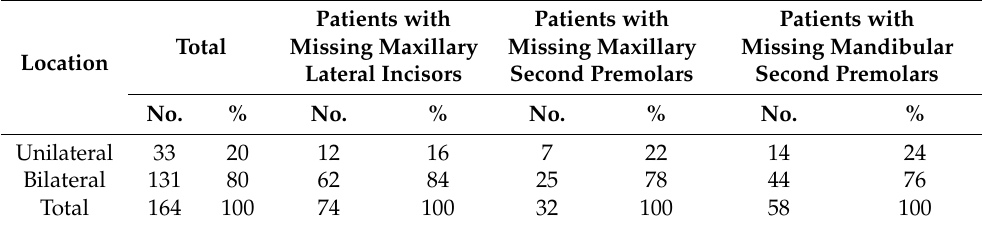
Table 4. Patterns of missing teeth by